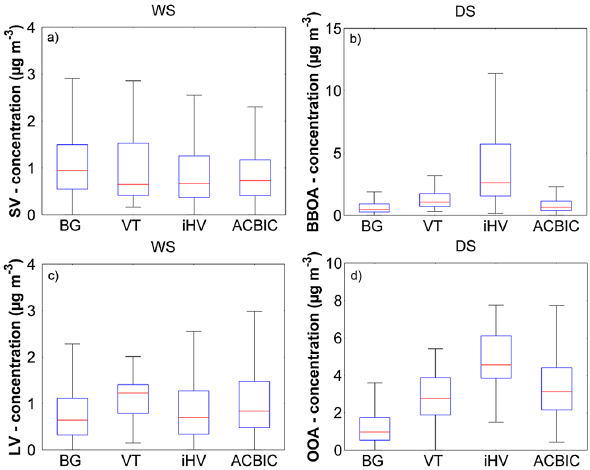
Fig. 11. Organic group characterisation for the four source regions, i.e., BG, VT, iHV and ACBIC, for both the wet season (WS) and the dry seasons (DS). The box plots indicate of 25th and 75th per- centiles and the line within the box marks the median. Whiskers present 5th and 95th